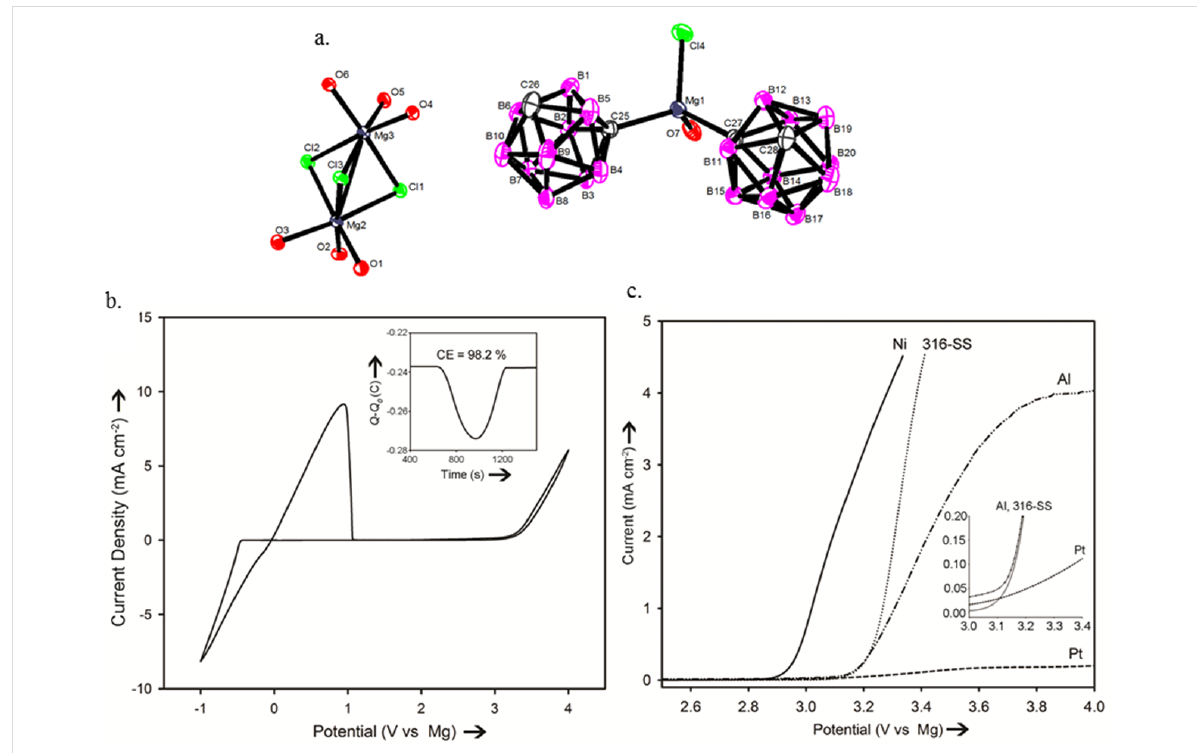
Figure 6: a) X-ray crystal structure of 1-(1,7-C 2 B 10 H 11 ) MgCl. Hydrogen atoms and THF carbon atoms are omitted for clarity. b) Cyclic voltammo- gram in THF solution (inset: charge balance of Mg deposition/stripping). c) Linear sweep voltammograms of Mg(C 2 B 10 H 11 )Cl/THF on Pt, Stainless steel (316-SS), Ni and Al electrodes (inset: expanded view of the oxidation onset). Reprinted with permission from [35]. Copyright 2012 Wiley-VCH Verlag GmbH & Co. KGaA, Weinheim.